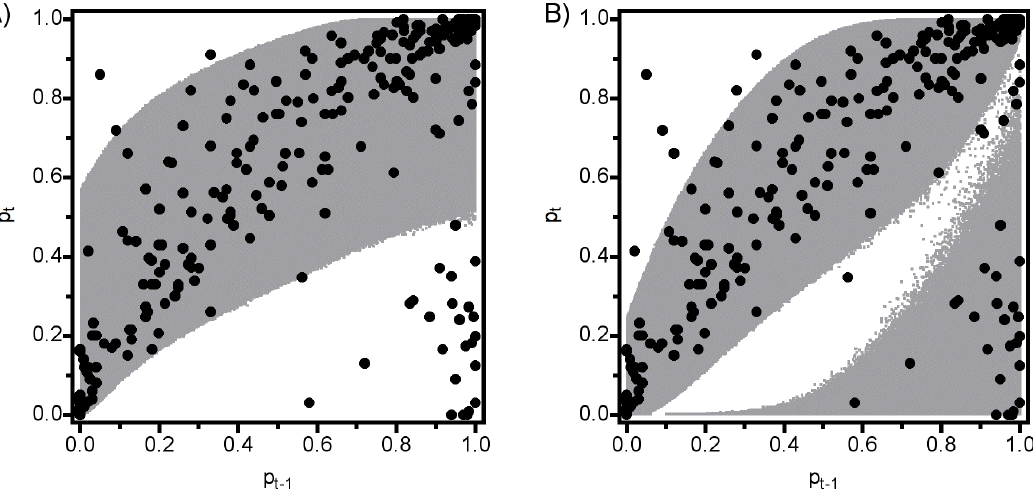
Figure 6. Observed distribution of M.californianus abundance at time t as a function of abundance the previous year (black points), overlaid on the approximate 95% prediction interval (gray points) derived from one million iterations for each 0.002 increment. A) a standard model with uniform stochasticity, B) a model with density-linked stochasticity. Because the probability distribution for density-linked stochasticity is multimodal, confidence envelopes were derived by summing bins from highest to lower probability until the sum exceeded 95%. Note the large number of observed points outside the 95% contour (lower right) and the lack of observed points in large areas inside the 95% contour for the uniform model.